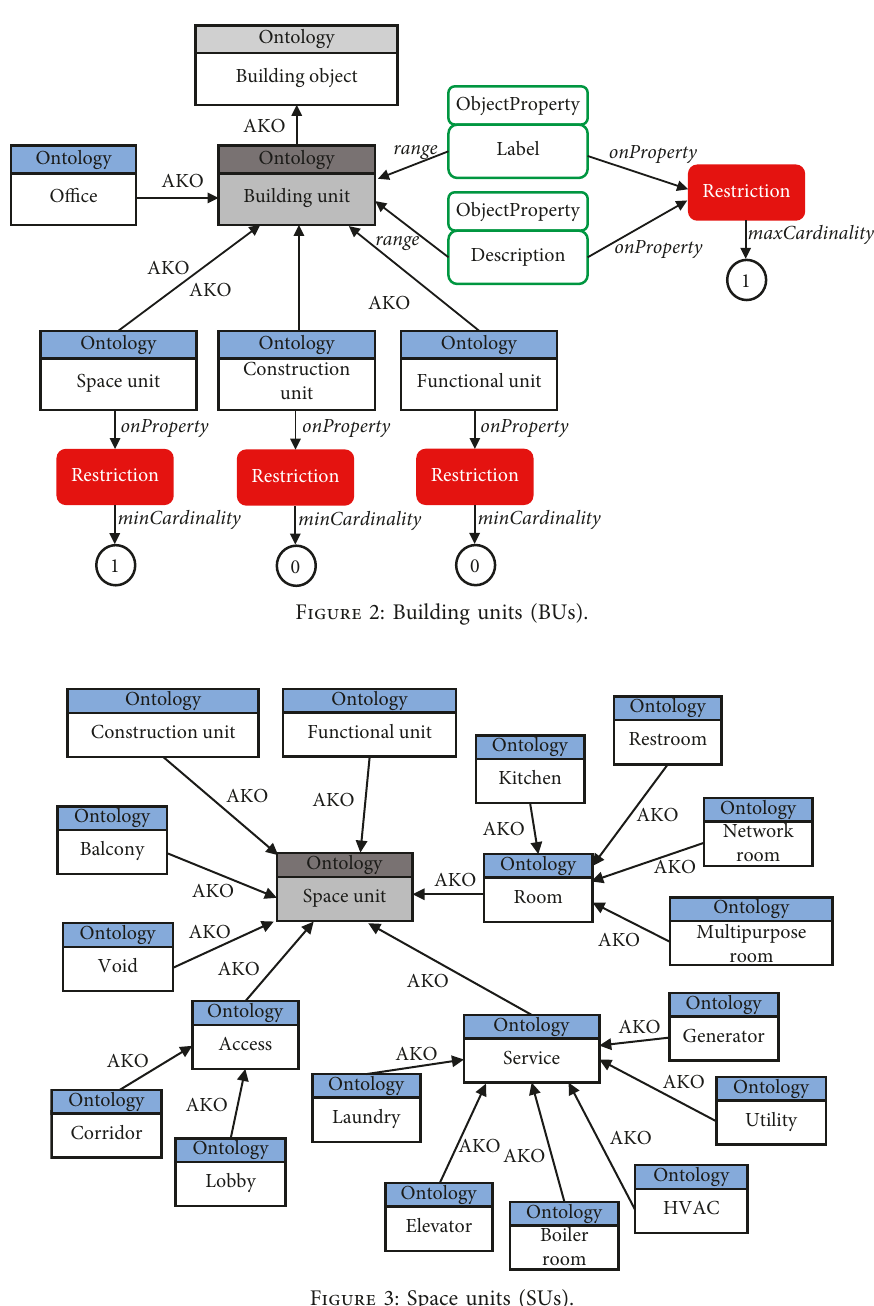
Figure 3: Space units